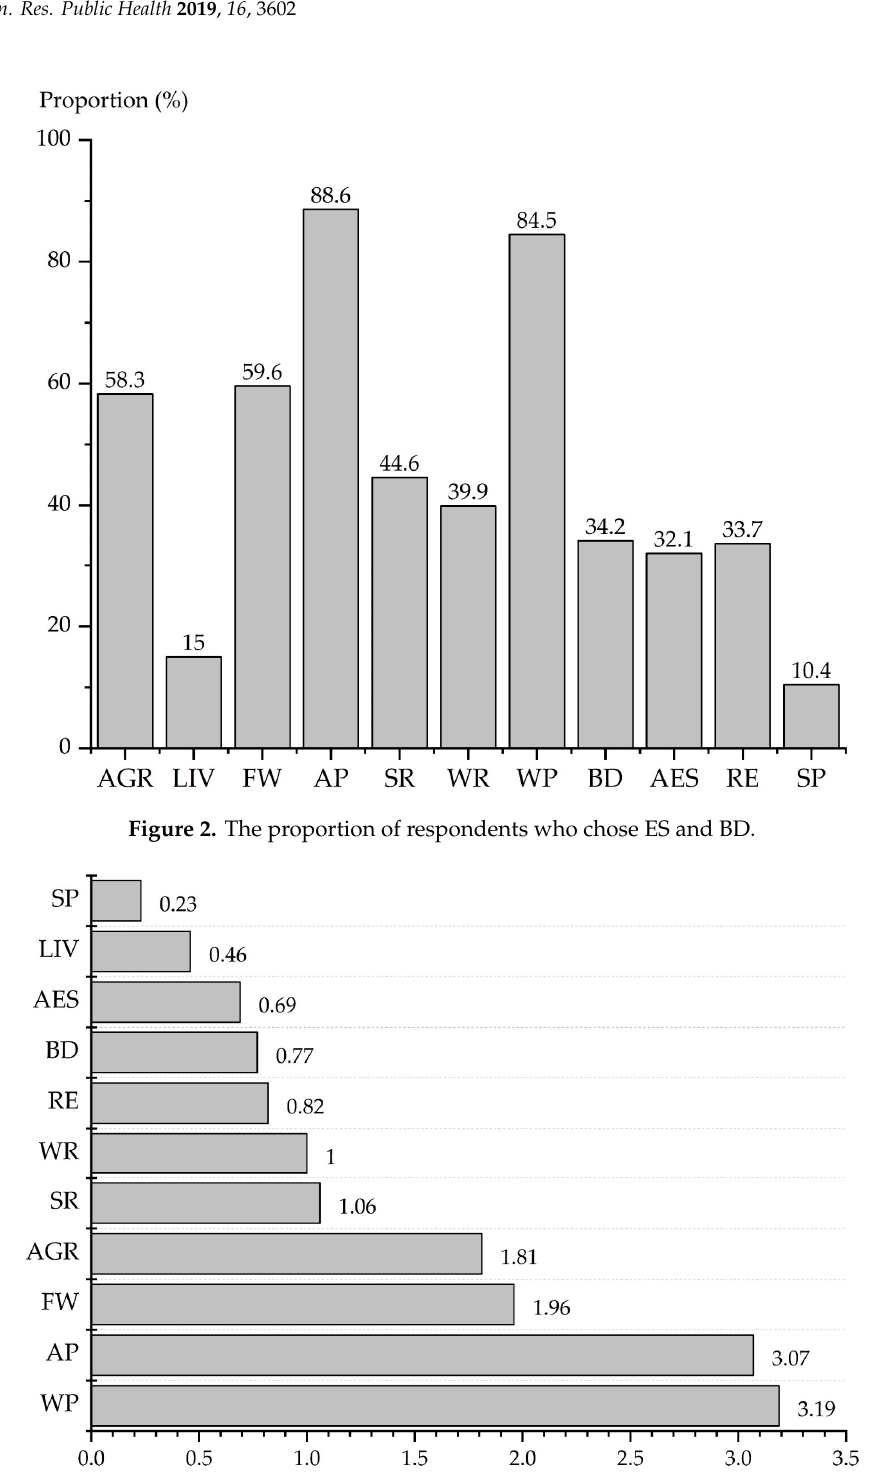
Figure 3. The importance scores of ten ES and BD.